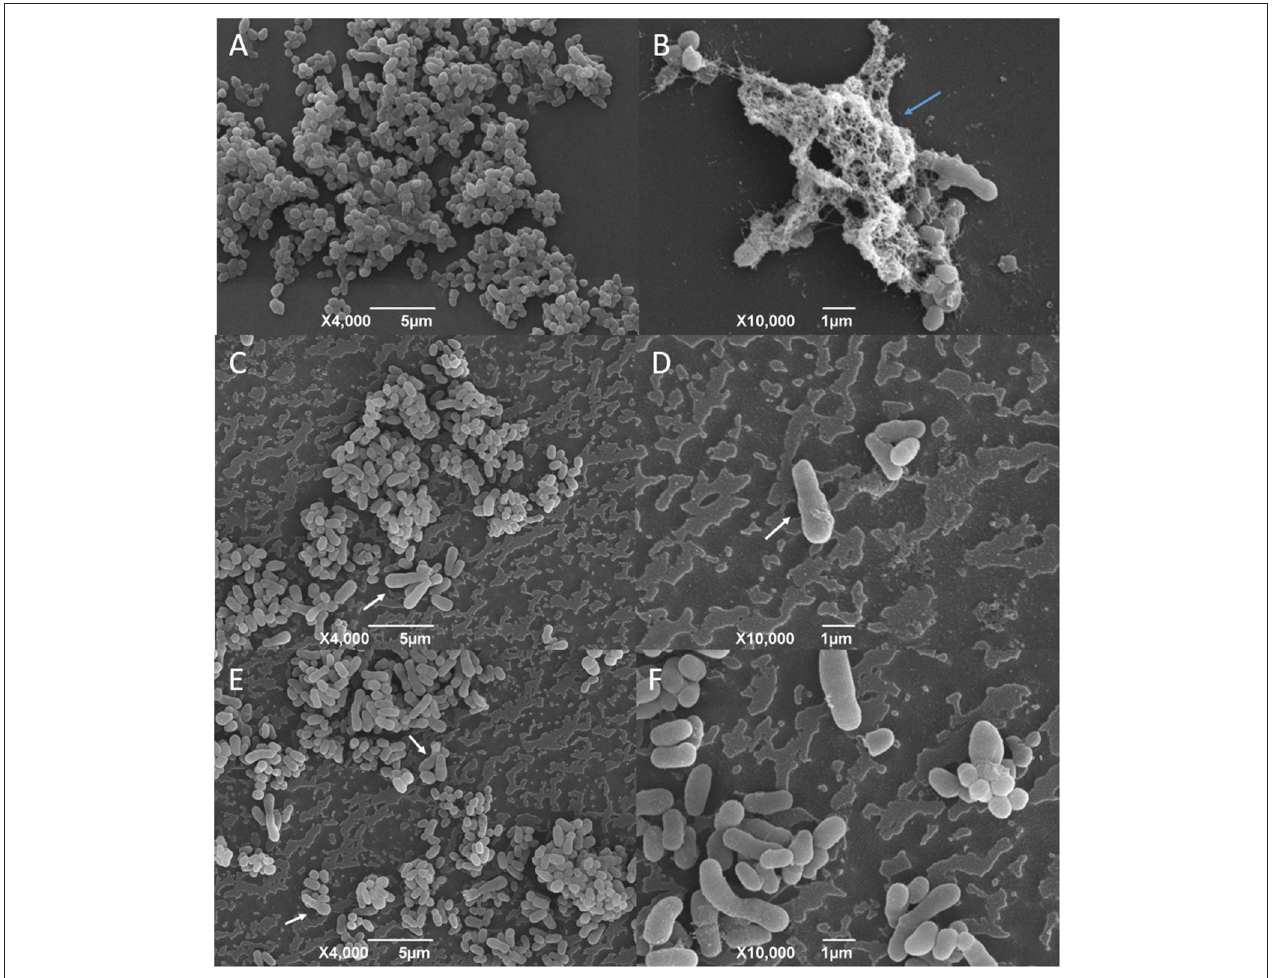
FIGURE 7 | SEM analysis of C. pseudotuberculosis biofilm treated or not with supercritical red propolis. (A) and (B) represent the bacterial biofilm without treatment, and (C–F) show the biofilms treated with the red propolis supercritical extract. The blue arrow indicates the presence of an exopolysaccharide matrix in a mature biofilm. The white arrows indicate cellular deformities not seen in the planktonic bacterial cells and in the not-treated